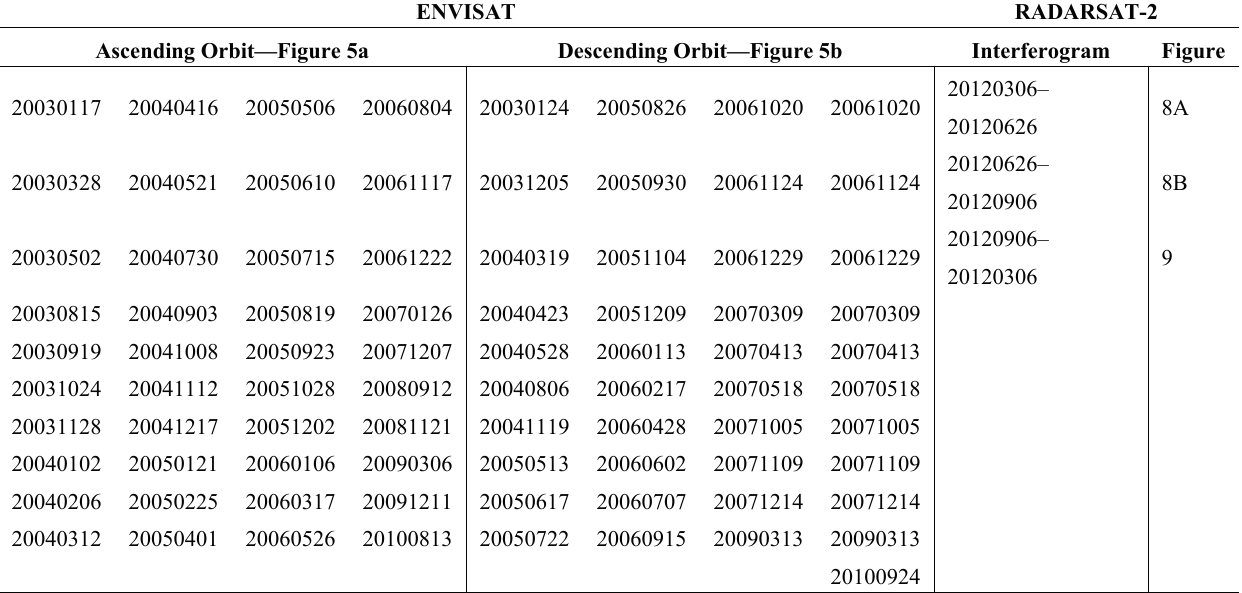
Table 2. The ENVISAT 2003–2010 dataset ( left ); and list of interferograms created using four 2012 RADARSAT-2 images (6 March; 26 June; 6 September; 11 December) ( right ). ENVISAT